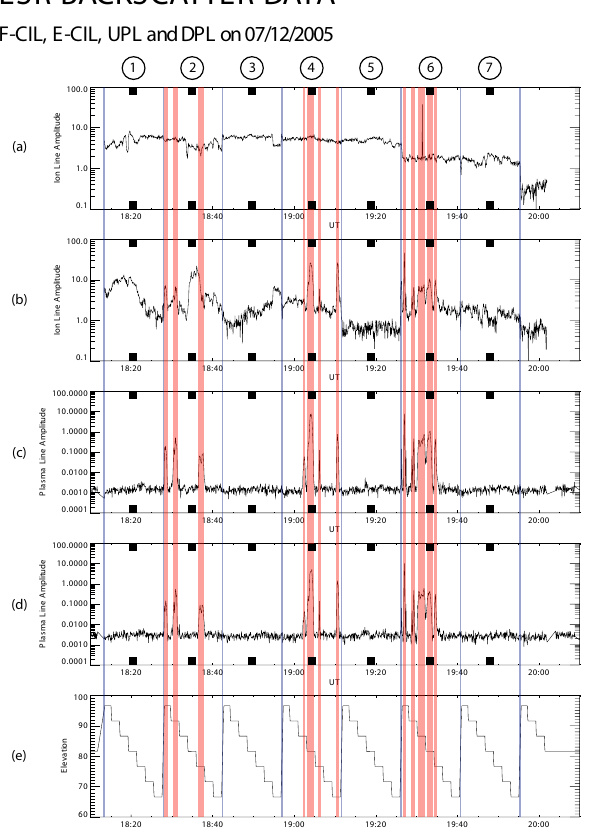
Fig. 5. Ion and plasma line amplitudes from 15 August 2007 (in- terval 3). Panels (a) to (d) show F-region central ion line, E-region central ion line, and the upshifted and downshifted plasma line re- spectively. Panel (e) again shows the elevation angle (angular dis- placement) of the 32m dish. The demarcation of the scanning cy- cles and the labelling of field-aligned are as for Fig. 4, with the red bars again highlighting the spectral enhancements. Definite en- hancements were seen in pointing directions from FA+14 to FA+4 and in FA. As for data from interval 1, shown in Fig. 4, these en- hancements occurred mainly in the